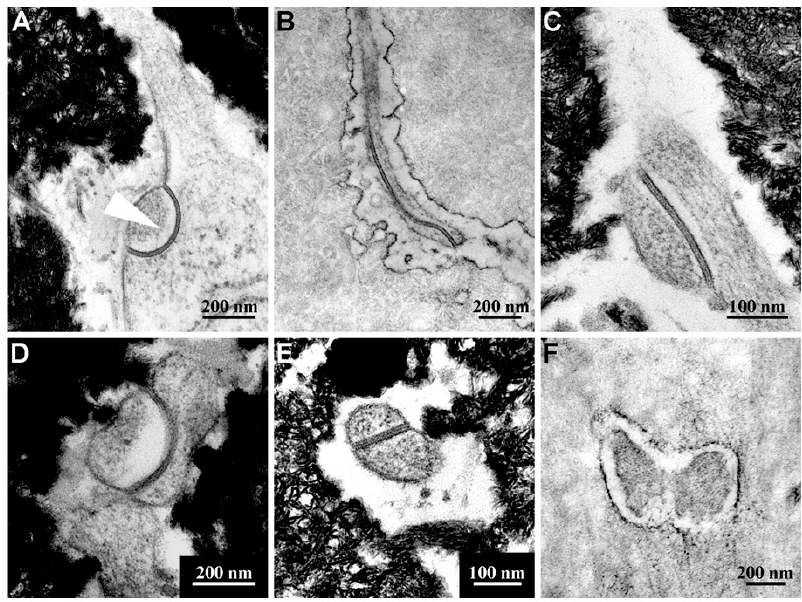
Figure 10. TEM micrograph panel representative of the abundance of gap junctions ( A – E ) with respect to simple contacts ( F ) in overloaded frogs. The head ‐ arrow in ( A ) indicates the tip of a cytoplasmic process protruding in a cell body of an adjacent osteocyte showing an “invaginated finger ‐ like” junction. Samples in ( B ) and ( F ) are decalcified.